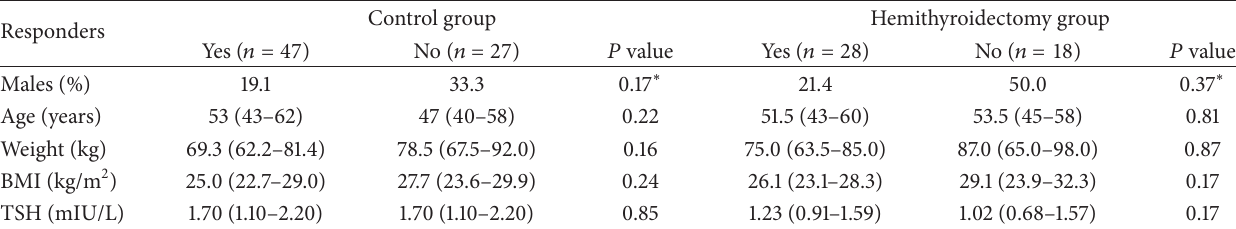
Table 1: Comparison between responders and nonresponders of the study groups.